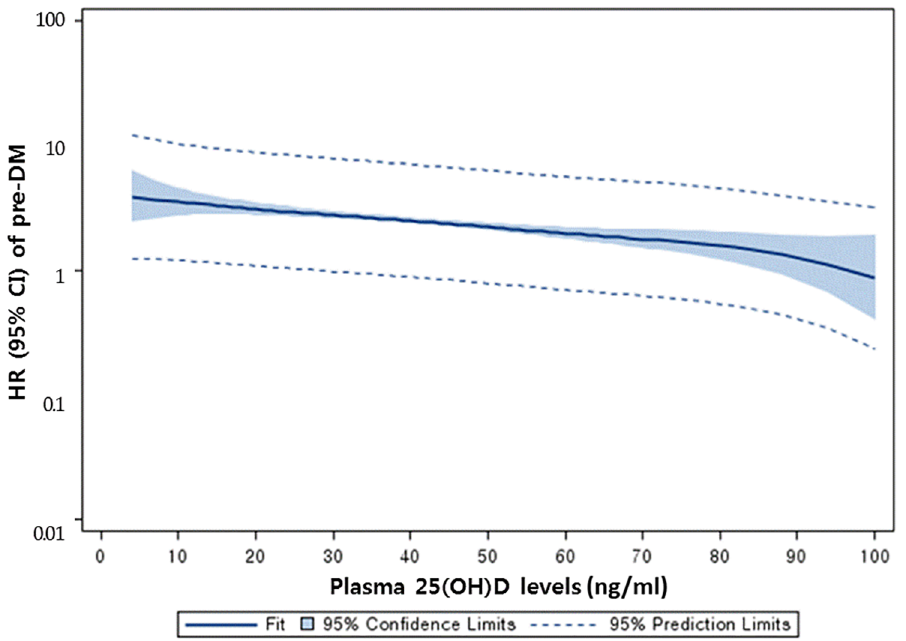
Fig 2. Hazard ratio for pre-diabetes according to plasma 25(OH)D concentration at baseline, Rancho Bernardo CA, 1997–2009.